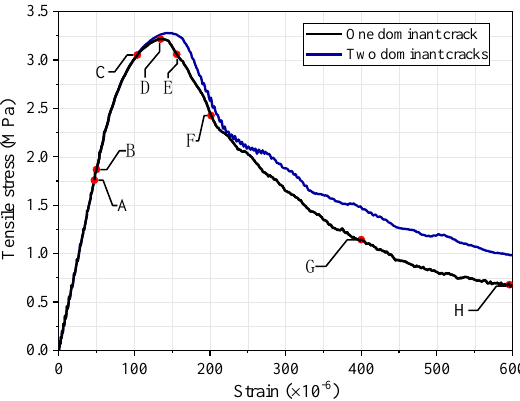
Figure 8. Failure modes of the specimens under tension: ( a ) simulation result (with one dominant crack); ( b ) simulation result (with two dominant cracks).